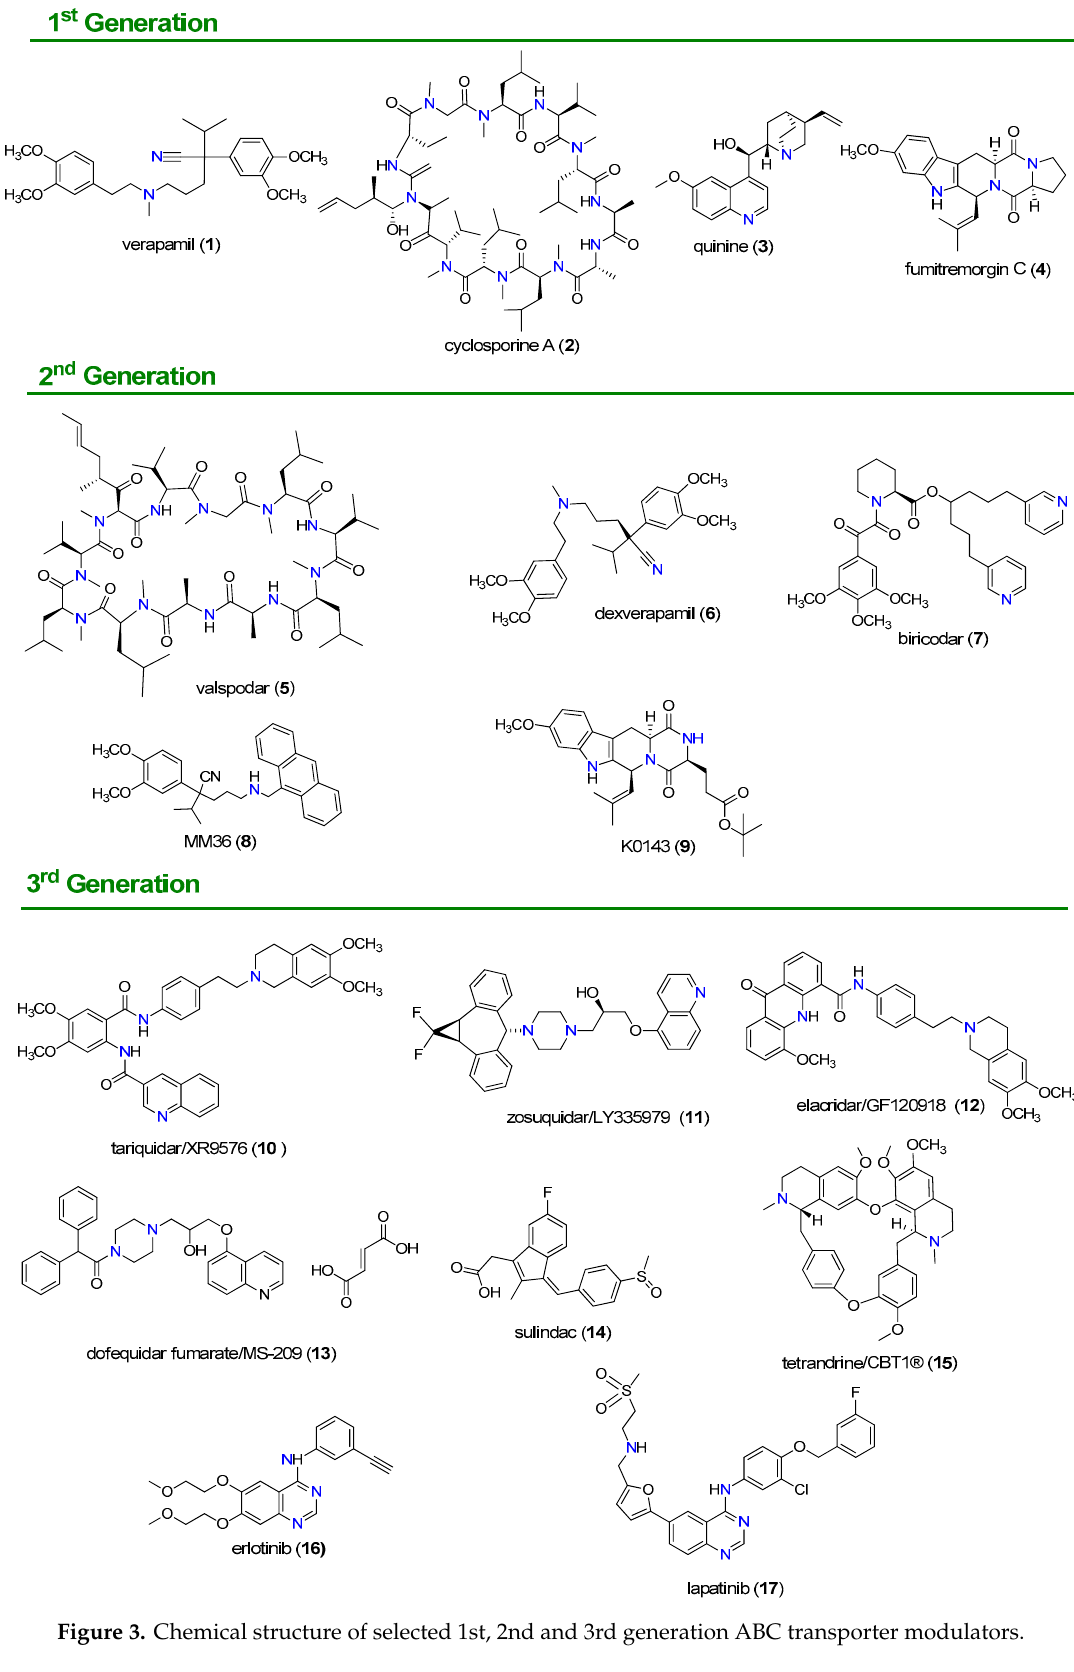
Figure 3. Chemical structure of selected 1st, 2nd and 3rd generation ABC transporter modulators.